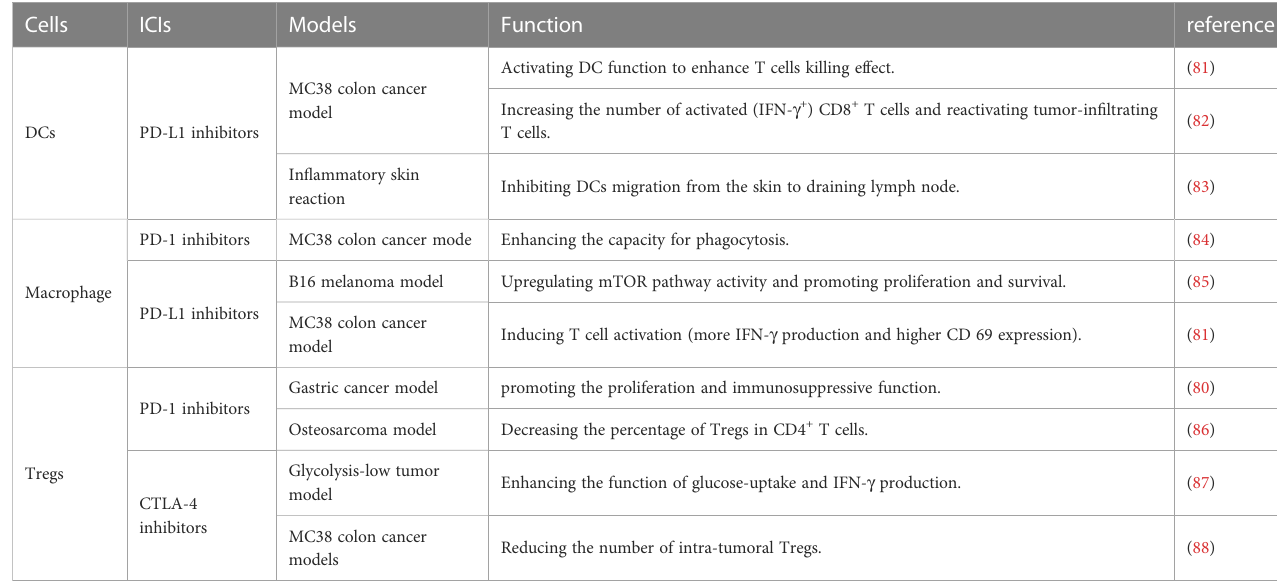
TABLE 4 The effect of each ICI on each cell type.